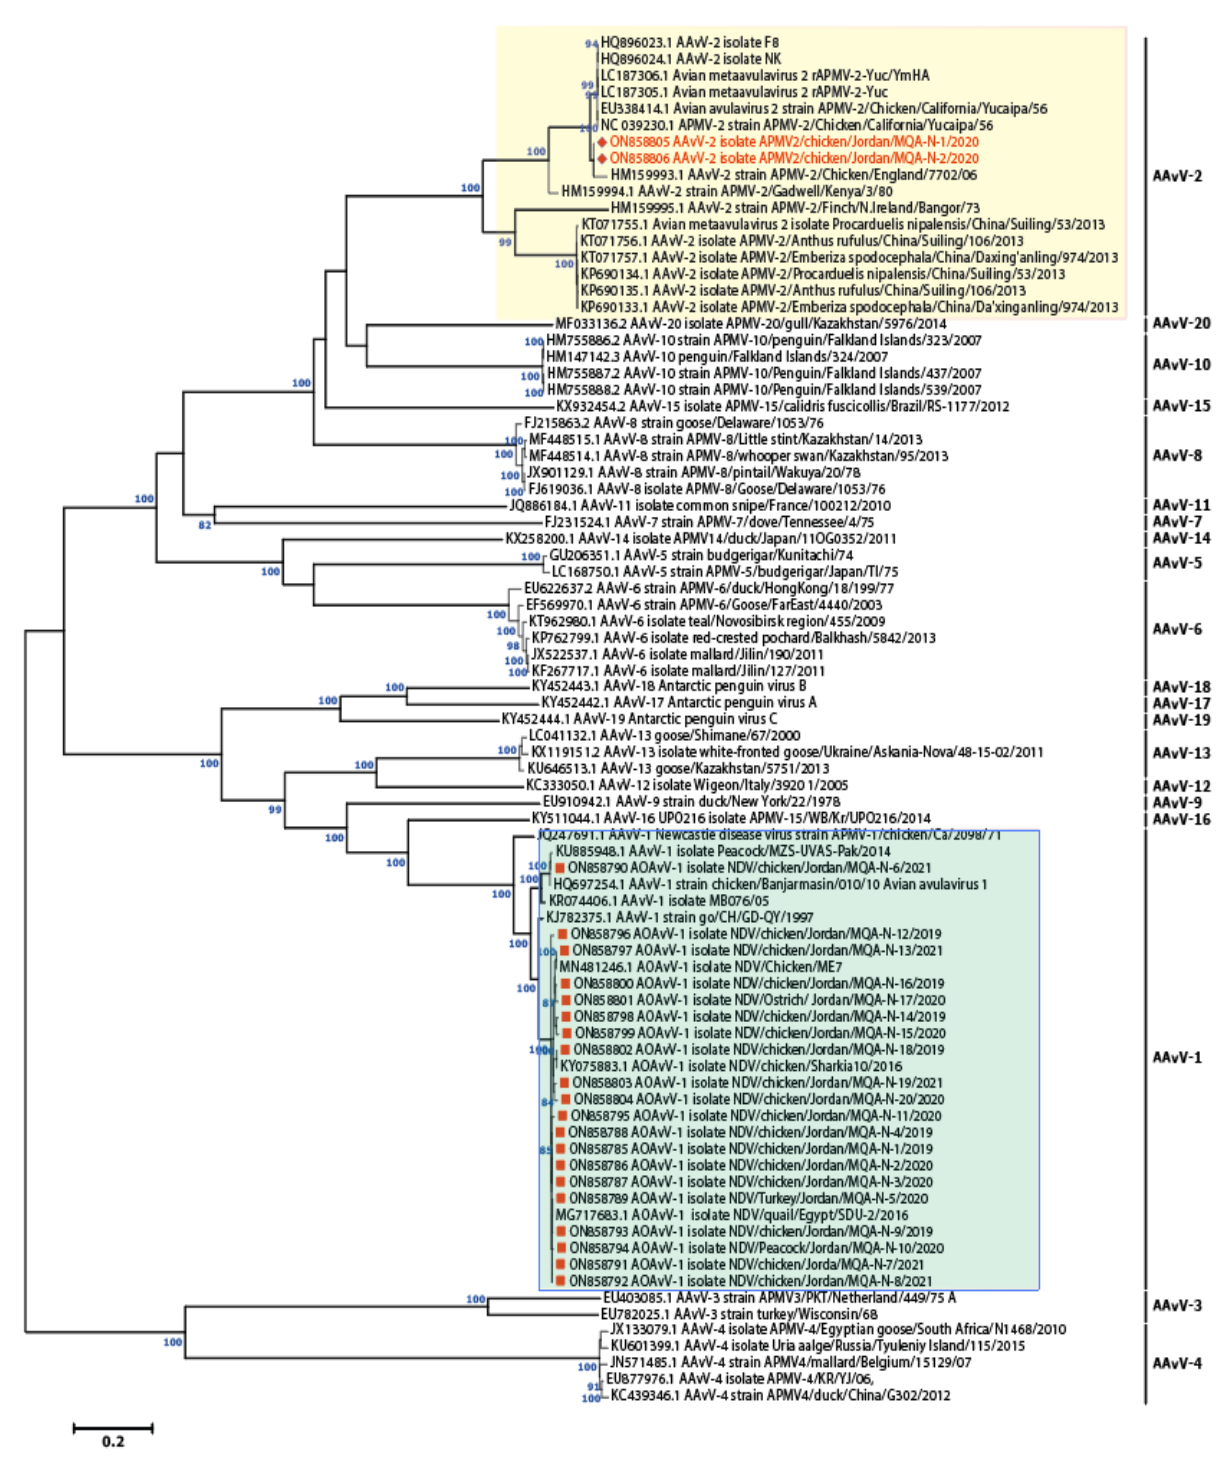
Figure 2. Phylogenomic revealed the clustering of 20 isolates within the AOAVv-1 while two isolates were allocated within AAvV-2/APMV-2. Unrooted phylogenetic trees were generated using the distance-based using maximum likelihood method and MEGA 6 software. Statistical support for tree branches was assessed by bootstrap analysis using 1000 replications of bootstrap re-sampling; numbers above branches indicate neighbor-joining bootstrap values that were ≥ 80%; the tree is drawn to scale, with branch lengths measured in the number of substitutions per site. The reported AAvV-1 isolates in this study are marked with red square within light green box; however, AAvV-2 isolates are marked with red hexagon labelled within light yellow box.